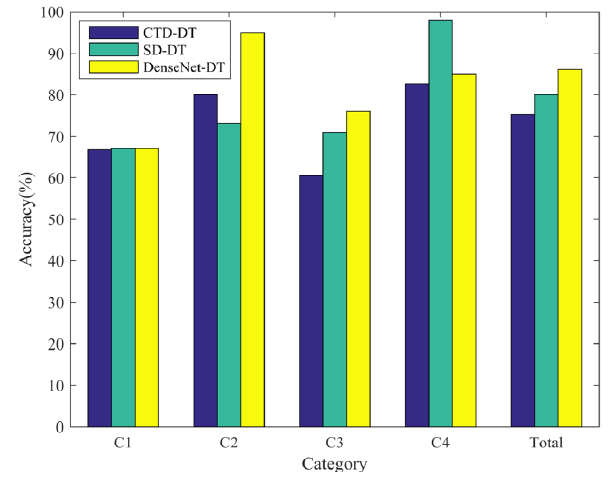
Figure 14. Comparison of CTD-DT, SD-DT and DenseNet-DT results.